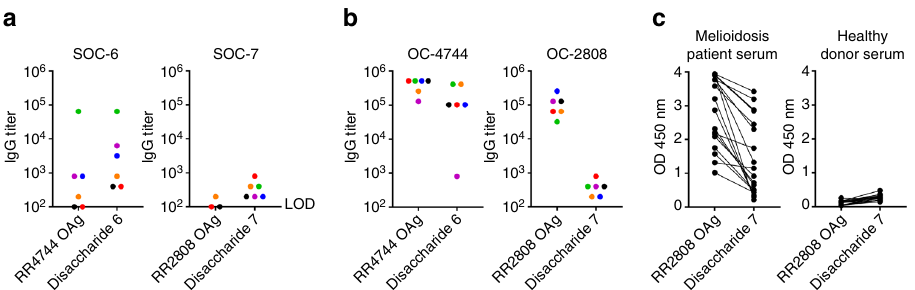
Fig. 8 Mouse and human immune responses to disaccharides and OAgs. BALB/c mice ( n = 6 per group) were immunized with a SOC-6 and SOC-7 or b OC-4744 and OC-2808. ELISAs were used to quantitate immune serum IgG titers. Colored dots represent the mean end point titers for individual mice against the various target antigens. LOD, limit of detection. c Serum samples from culture-con fi rmed Thai melioidosis patients ( n = 18) and Thai healthy donors ( n = 18) were assayed for reactivity with the target antigens using single-dilution ELISAs. Connecting lines indicate identical Supplementary Methods. For the NMR spectra of new compounds, see Supplementary Figs. 13 – 166. mAb 4C7 production . mAb 4C7 was produced as previously described 63 . Brie fl y, BALB/c mice were intraperitoneally injected with 2×10 8 CFU of heat-inactivated